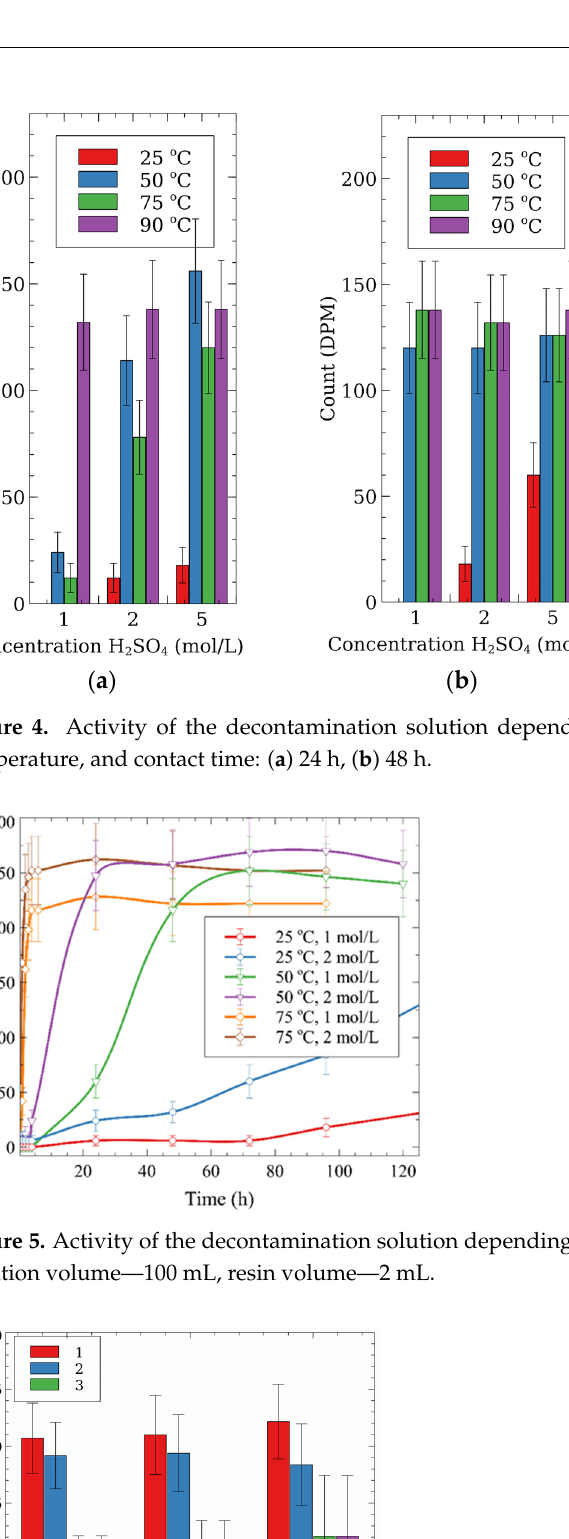
Figure 5. Activity of the decontamination solution depending on the time of contact with the resin. Solution volume—100 mL, resin volume—2 mL.